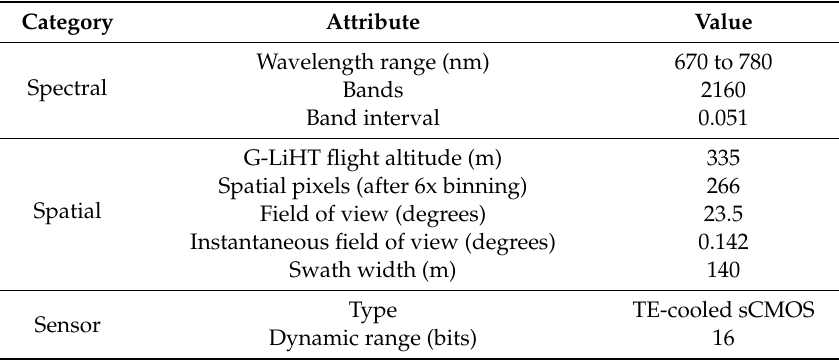
Table 1. FIREFLY